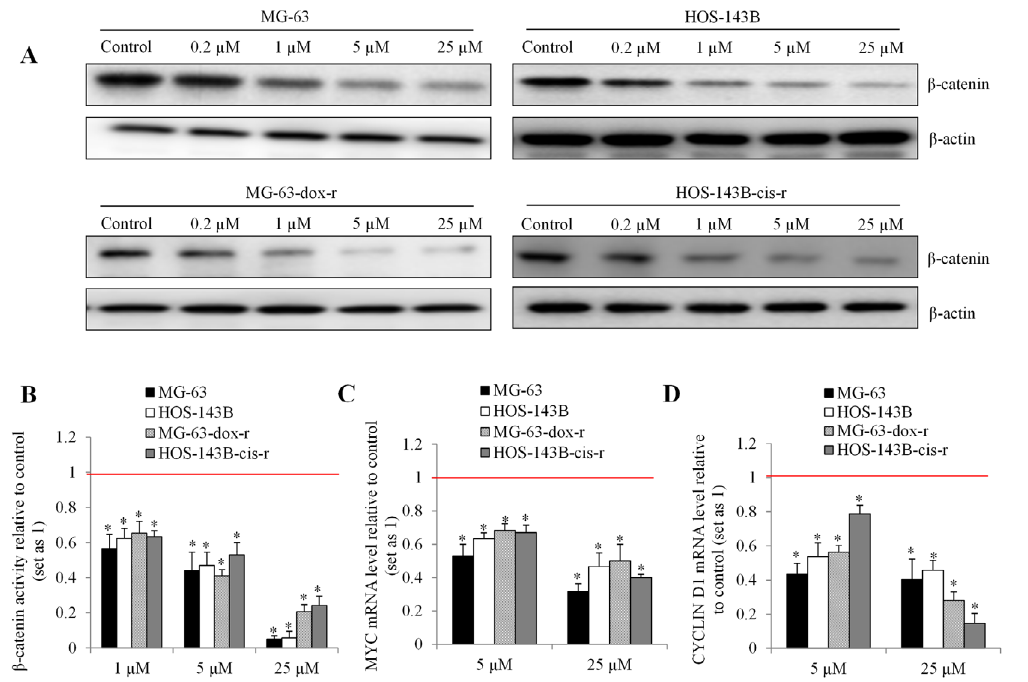
Figure 5 – Niclosamide decreases β-catenin level and activity in parental and chemo-resistant osteosarcoma cells. (A) Western blot showing the decreased β-catenin level in MG-63, MG-63-dox-r, HOS-143B and HOS-143B-cis-r. Cells were treated with niclosamide for 24 h prior to western blot analyses. (B) Niclosamide significantly decreases β-catenin activity in parental and chemo-resistant osteosarcoma cells. TOP-flash luciferase reporter assay of osteosarcoma cells treated with niclosamide for 24 hours. (C and D) Niclosamide significantly decrease mRNA levels of MYC and CYCLIN D1. *, p<0.05, compared to control. Control was set up as 1. Unpaired Student’s t test was conducted.